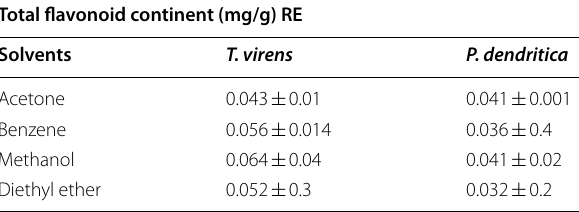
Table 3 Quantitative phenolic estimation in T. virens and P. dendritica across organic extracts (acetone, methanol, diethyl Table 4 Quantitative flavonoid estimation in T. virens and